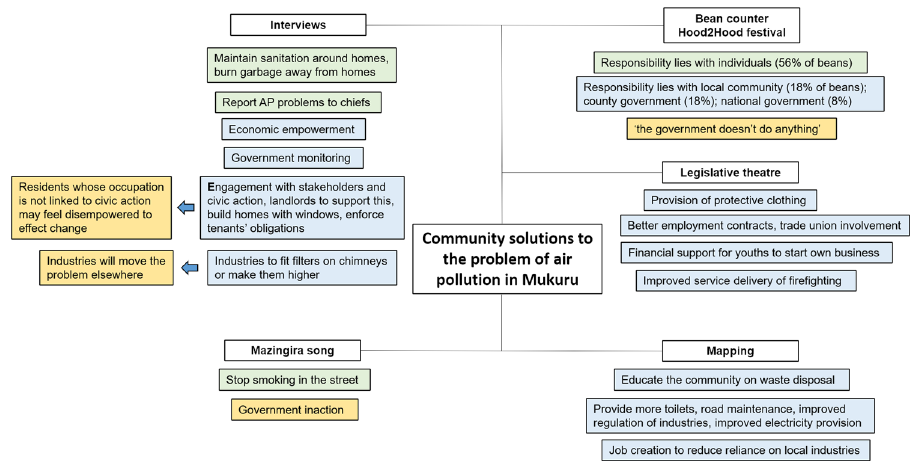
Fig. 8 Community solutions to the problem of air pollution in Mukuru, showing the method from which they were derived. Green boxes represent individual action. Blue boxes represent solutions requiring change at administrative or policy level. Orange boxes represent barriers to